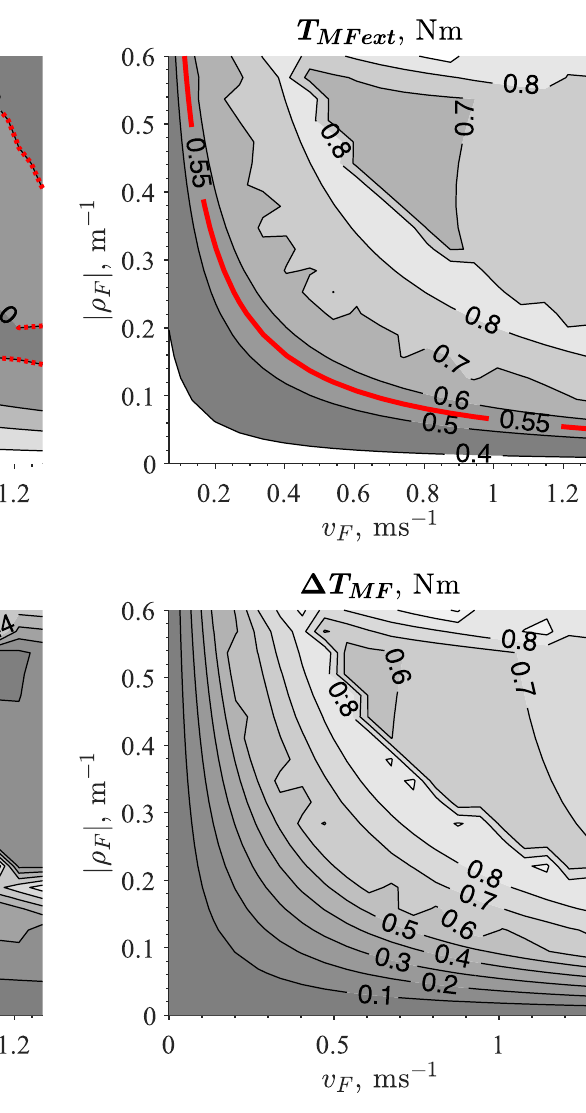
Fig. 15 Mapping of the motor torques at steady state circular manoeuvring with k TA = 1 . The top left plot is the torque map of the front motor at the inner side of the turn, the top right is the front outer motor torque map, the bottom left shows the mean front